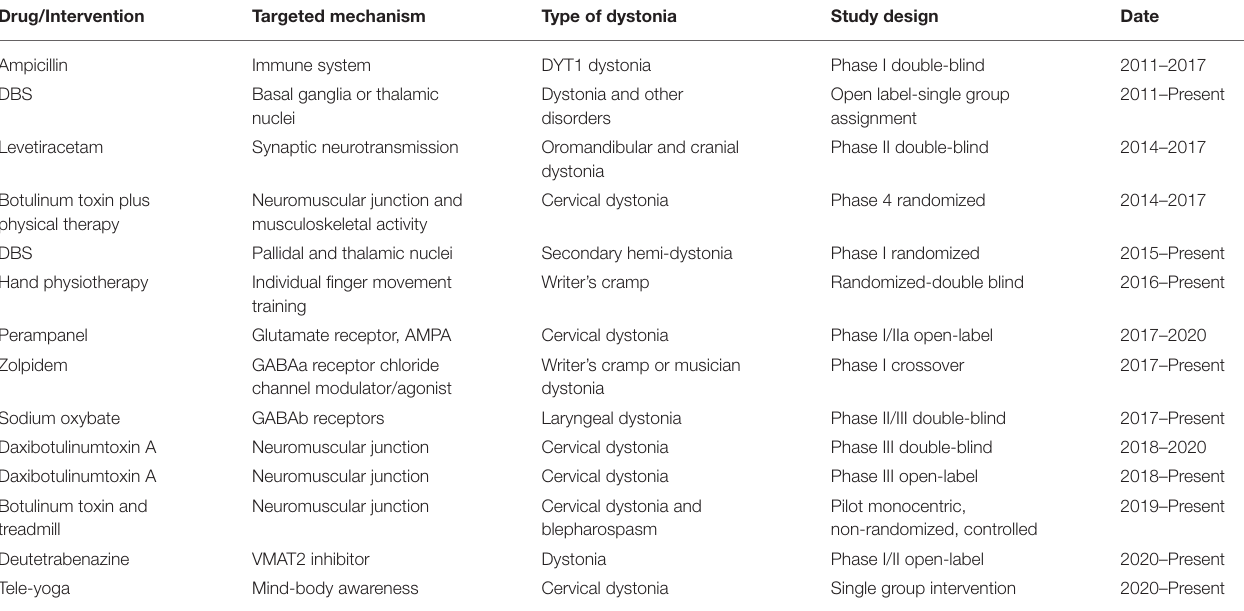
TABLE 1 | Selected clinical trials on dystonias (https://clinicaltrials.gov).